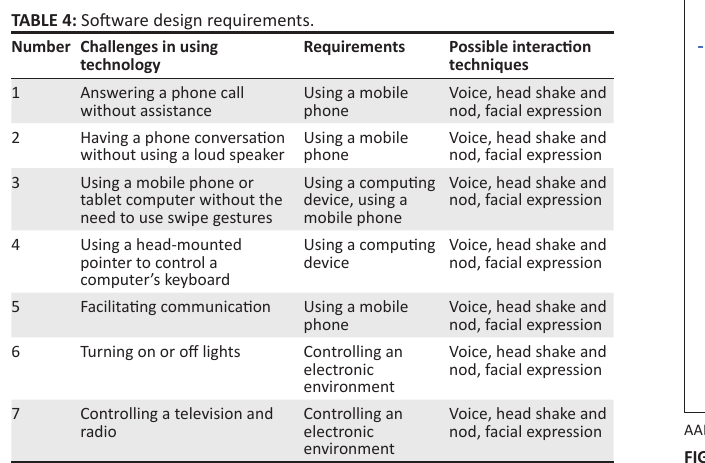
FIGURE 3: A framework for designing AAL services for individuals with disabilities.